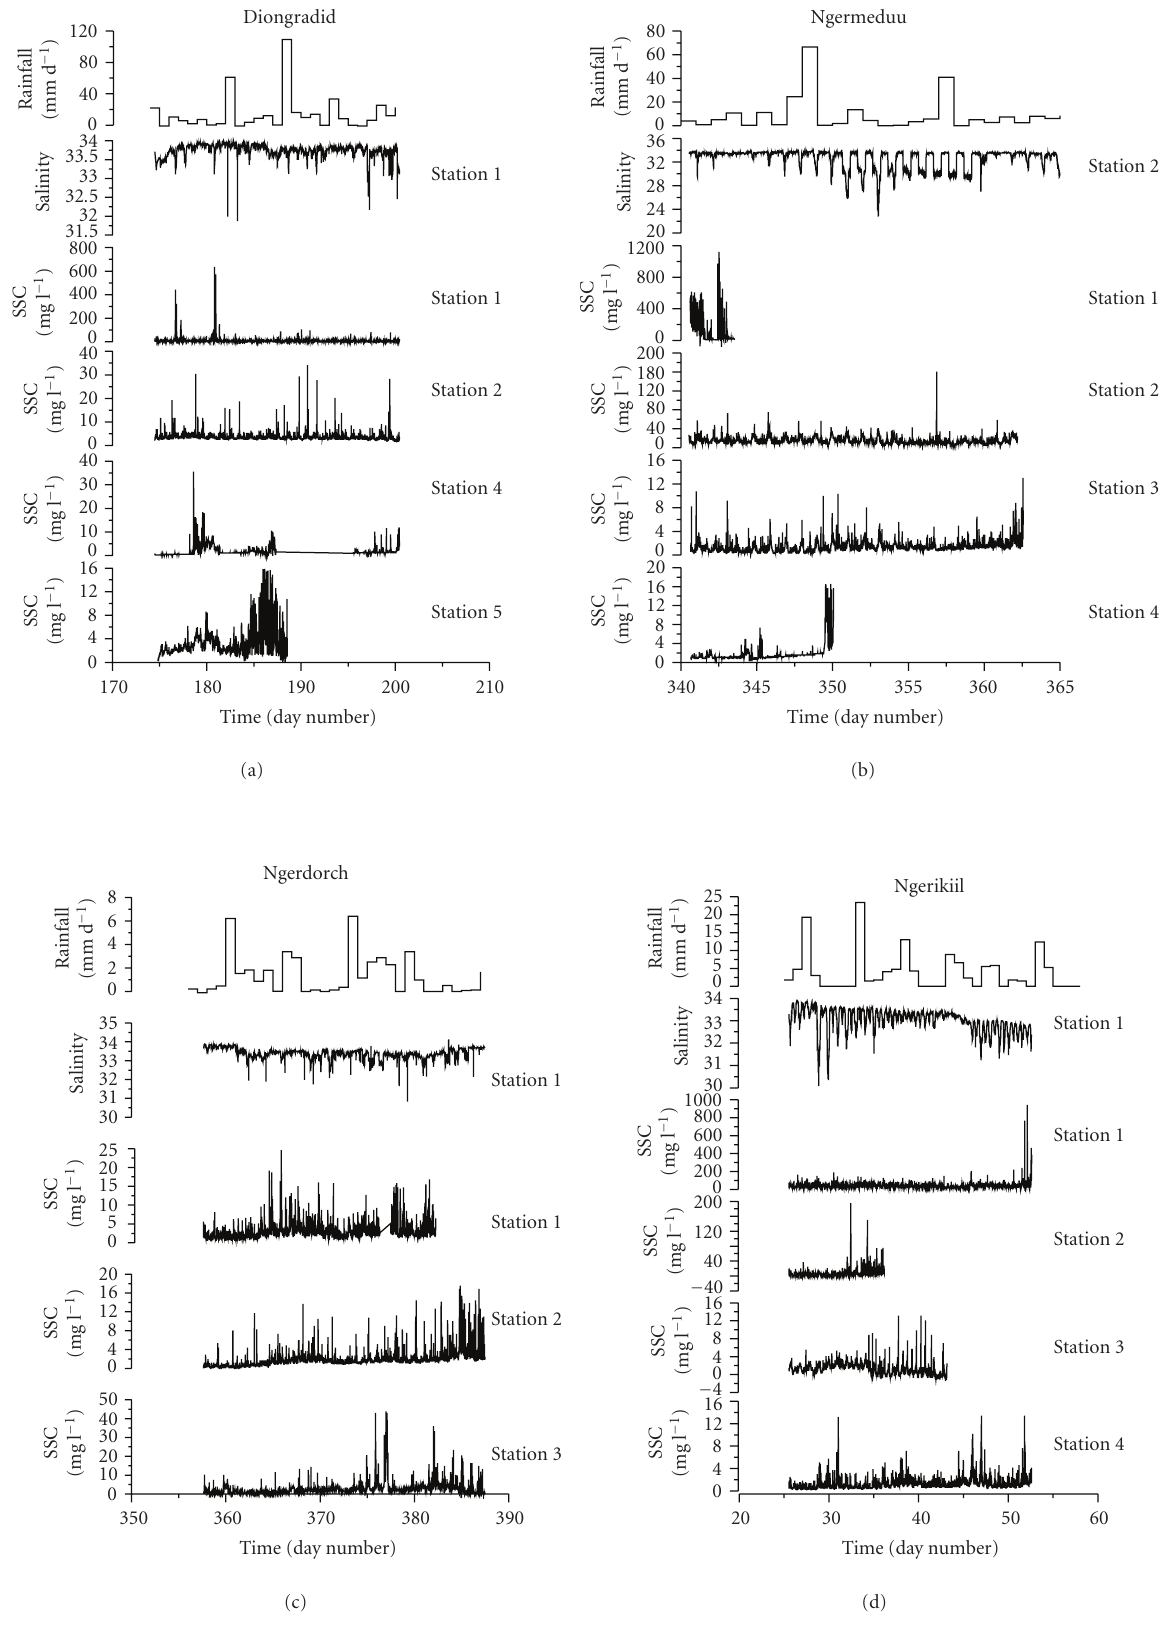
Figure 3: Time-series plot of rainfall, salinity and SSC at (a) Diongradid bay, (b) Ngermeduu bay, (c) Ngerdorch bay, (d) Ngerikiil